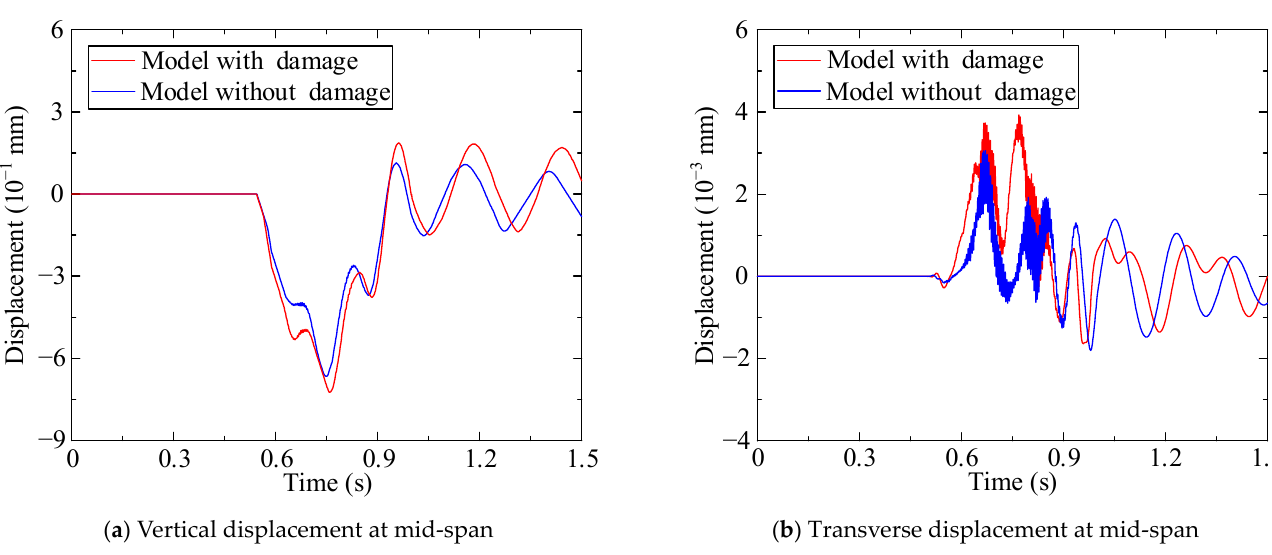
Figure 26. Responses of the composite beam at a train speed of 360 km/h in the case of T-2. Table 8. Comparison of maximum displacement at mid-span of composite beams.